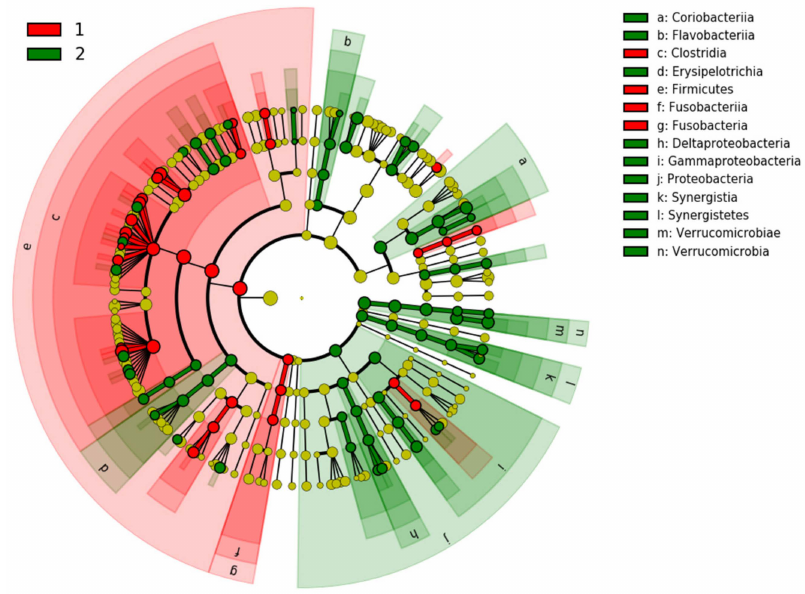
Figure 7. Cladogram generated by LEfSe shows the taxa differences between PD patients (2) and healthy controls (1). The central yellow dot in each cladogram represents kingdom; each successive circle is one step lower phylogenetically (phylum, class, order, family, and OTU). Regions colored in red indicate taxa enriched in controls compared to those enriched in PD patients marked with green